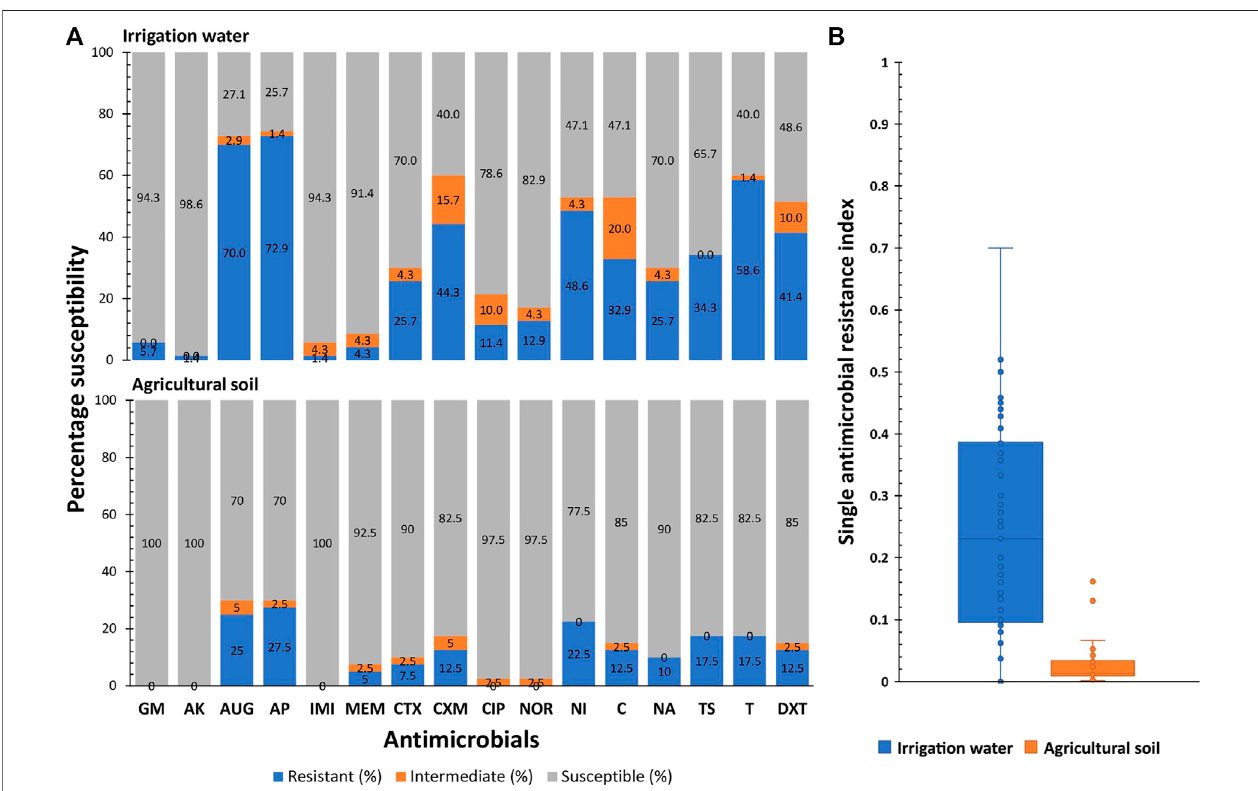
FIGURE3| Theantimicrobialsusceptibilitypro fi les (A) andsingleantimicrobialresistanceindex (B) ofthepathogenicstrainsof E.coli retrievedfromirrigationwater and agricultural soil samples. GM-gentamycin, AK-amikacin, AUG-amoxycillin-clavulanic acid, AP-ampicillin, IMI-imipenem, MEM-meropenem, CTX-cefotaxime, CXM- cefuroxime, CIP-cipro fl oxacin, NOR-nor fl oxacin, NI-nitrofurantoin, C-chloramphenicol, NA-nalidixic acid, TS-trimethoprim/sulphamethoxazole, T-tetracycline, DXT- doxycycline.